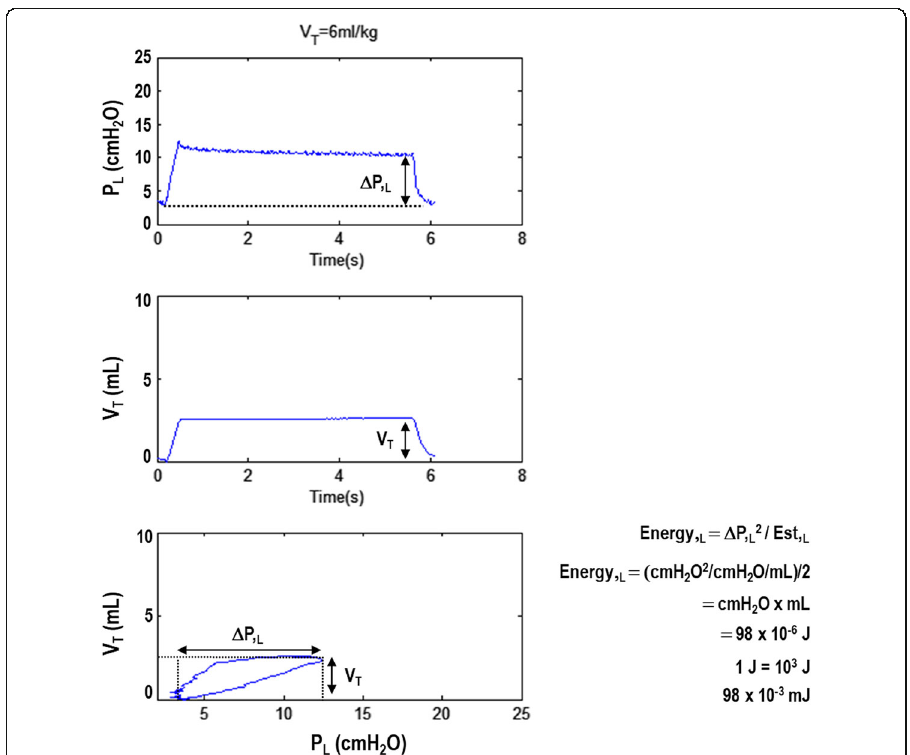
Fig. 3 Representative curves of transpulmonary pressure ( P , L ), tidal volume, and volume- P , L curve. V T , tidal volume; Δ P , L , transpulmonary driving pressure; Est, L , static lung elastance. Mechanical energy (Energy, L ) was calculated based on the equation described by Guerin et al. [19] and the simplified formula of Marini and Jaber [9] as Energy, L = Δ P , L2 /Est, L = Δ P , L2 /( Δ P , L / V T ) = Δ P , L × V T , which is the area of the rectangle. Therefore, one must compute the area of the rectangle and divide the result by two. This simplified equation estimates elastic work without taking into account resistive properties and